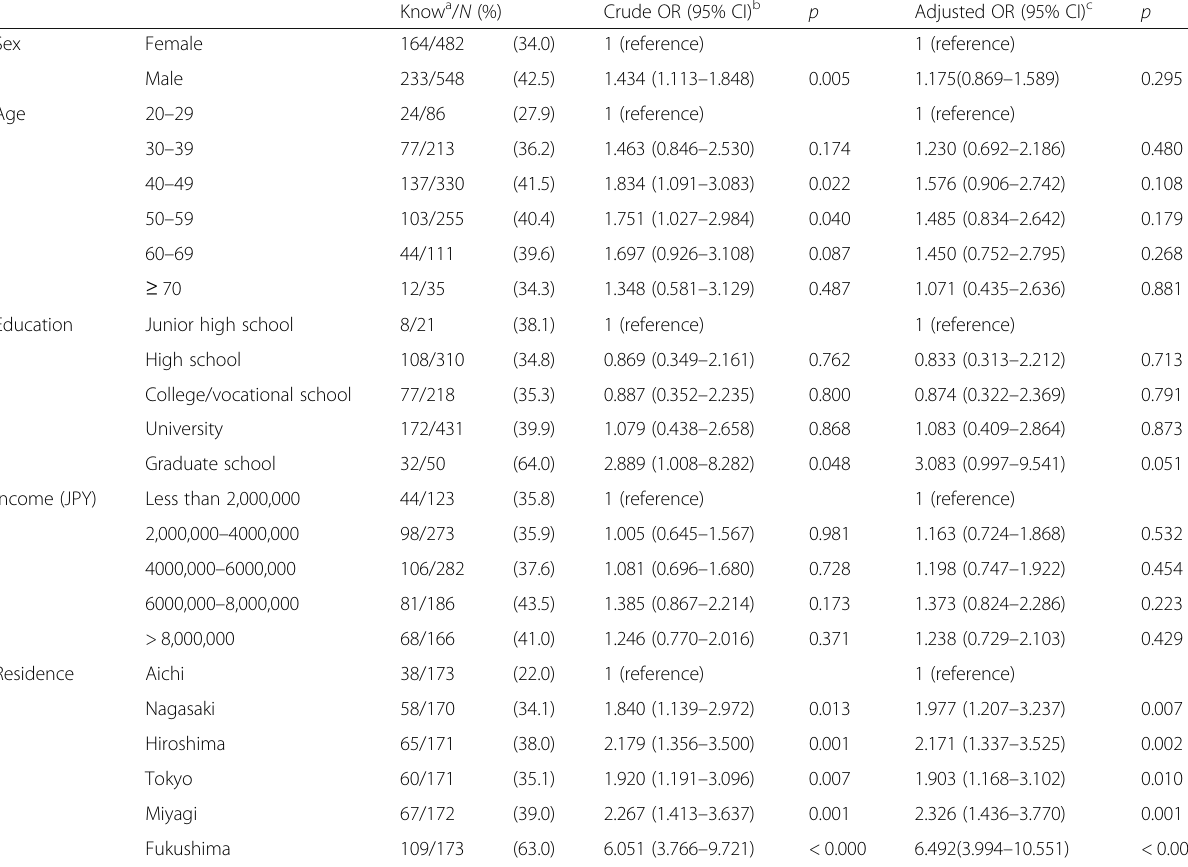
Table 4 Odds ratio (OR) and 95% confidence interval (CI) for awareness of the recognition level of the meanings of eight technical issues regarding